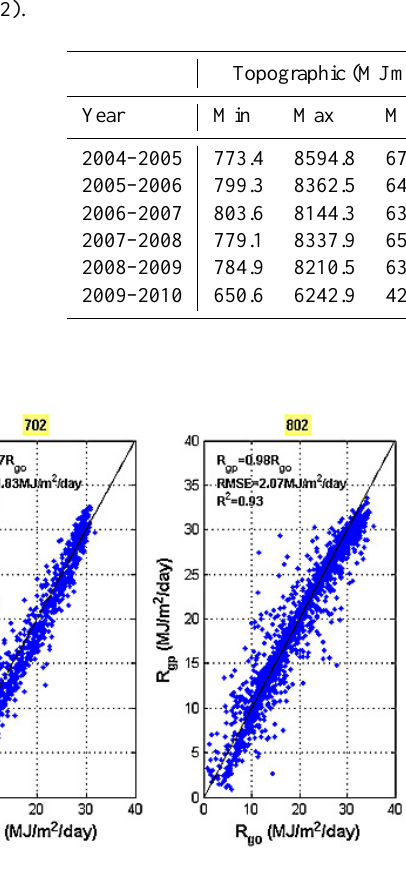
Fig. 4. Observed ( R go ) , and predicted ( R gp ) global daily radiation (MJm − 2 day − 1 ) at station 702 and 802 for the evaluation period